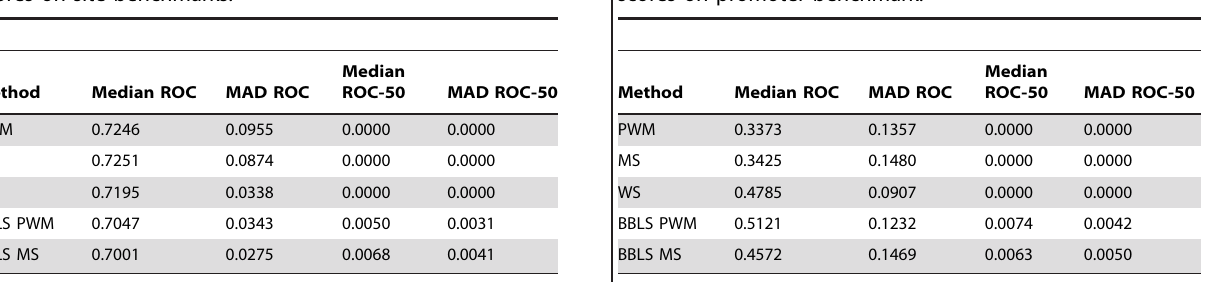
Table 3. Median and median absolute deviation (MAD) ROC scores on site benchmarks.